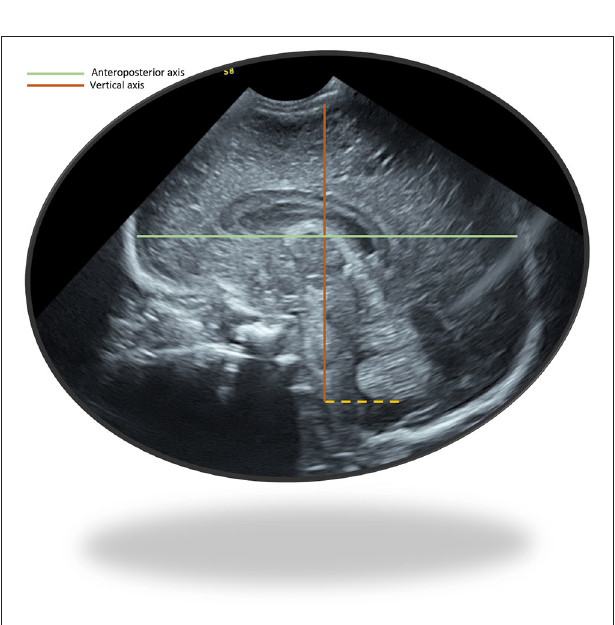
FIGURE 2 | Anteroposterior axis and vertical axis measured in an ultrasonographic sagittal